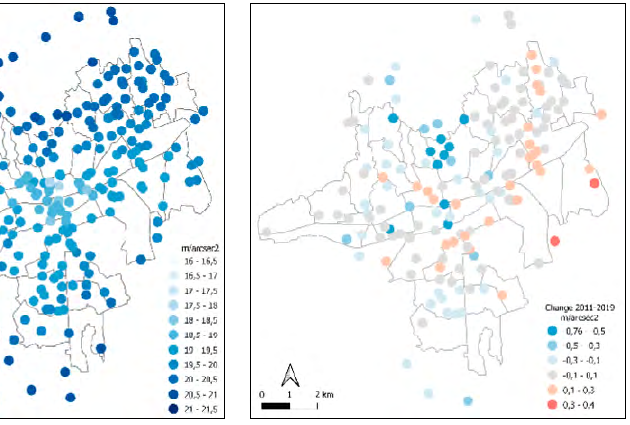
Figure 2.C. Common locations measurements in 2019 and changes in their background brightness between